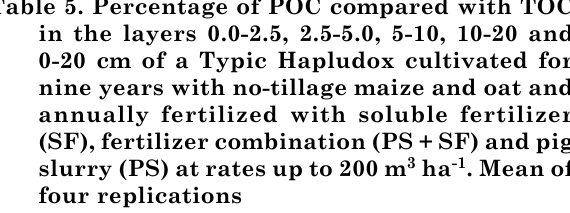
table 5. Percentage of POC compared with